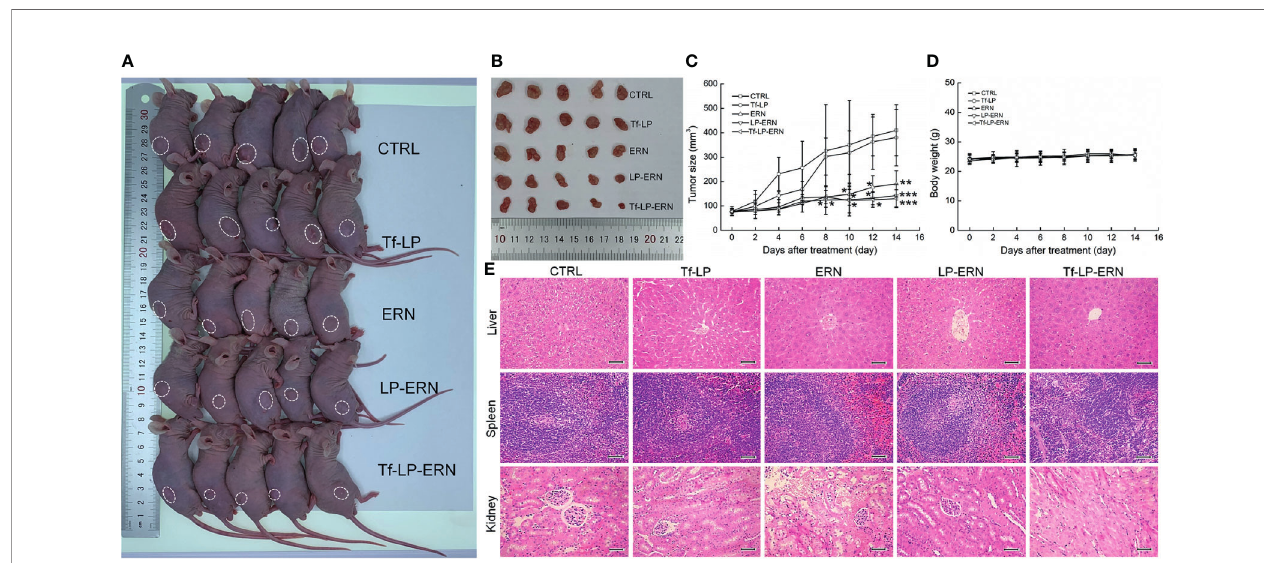
FIGURE 3 | ERN, LP-ERN and Tf-LP-ERN suppressed the tumor growth and showed biological safety in SMMC-7721-xenotransplanted BALB/c nude mice. The tumor volume comparison in (A) SMMC-7721-xenotransplanted BALB/c nude mice, and (B) their collected tumors. (C) Tf-LP-ERN signi fi cantly reduced the tumor volume of SMMC-7721-xenotransplanted BALB/c nude mice after 14-d administration (n = 5). Tf-LP, ERN, LP-ERN and Tf-LP-ERN showed no signi fi cant effects (D) on the body weight and (E) histopathologic changes including liver, spleen and kidney in SMMC-7721-xenotransplanted mice (magni fi cation: 200, scale bar: 50 m m). * P < 0.05, ** P < 0.01 and *** P < 0.001 vs. CTRL